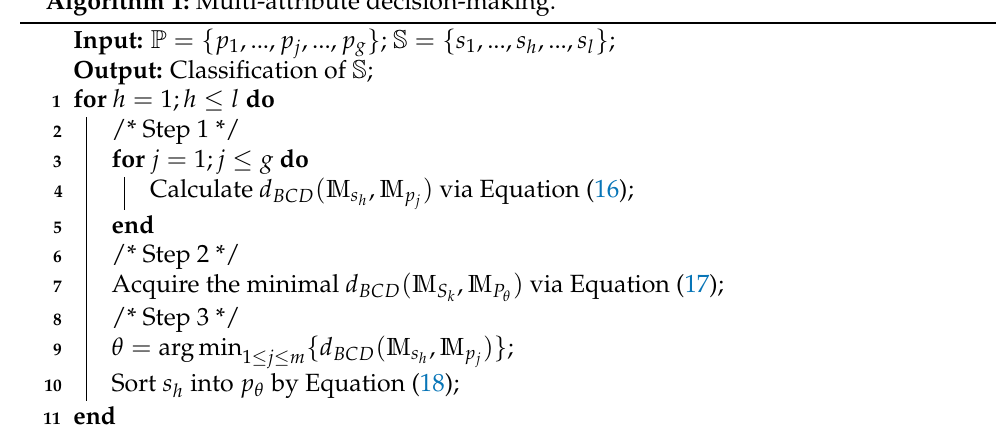
Algorithm 1: Multi-attribute